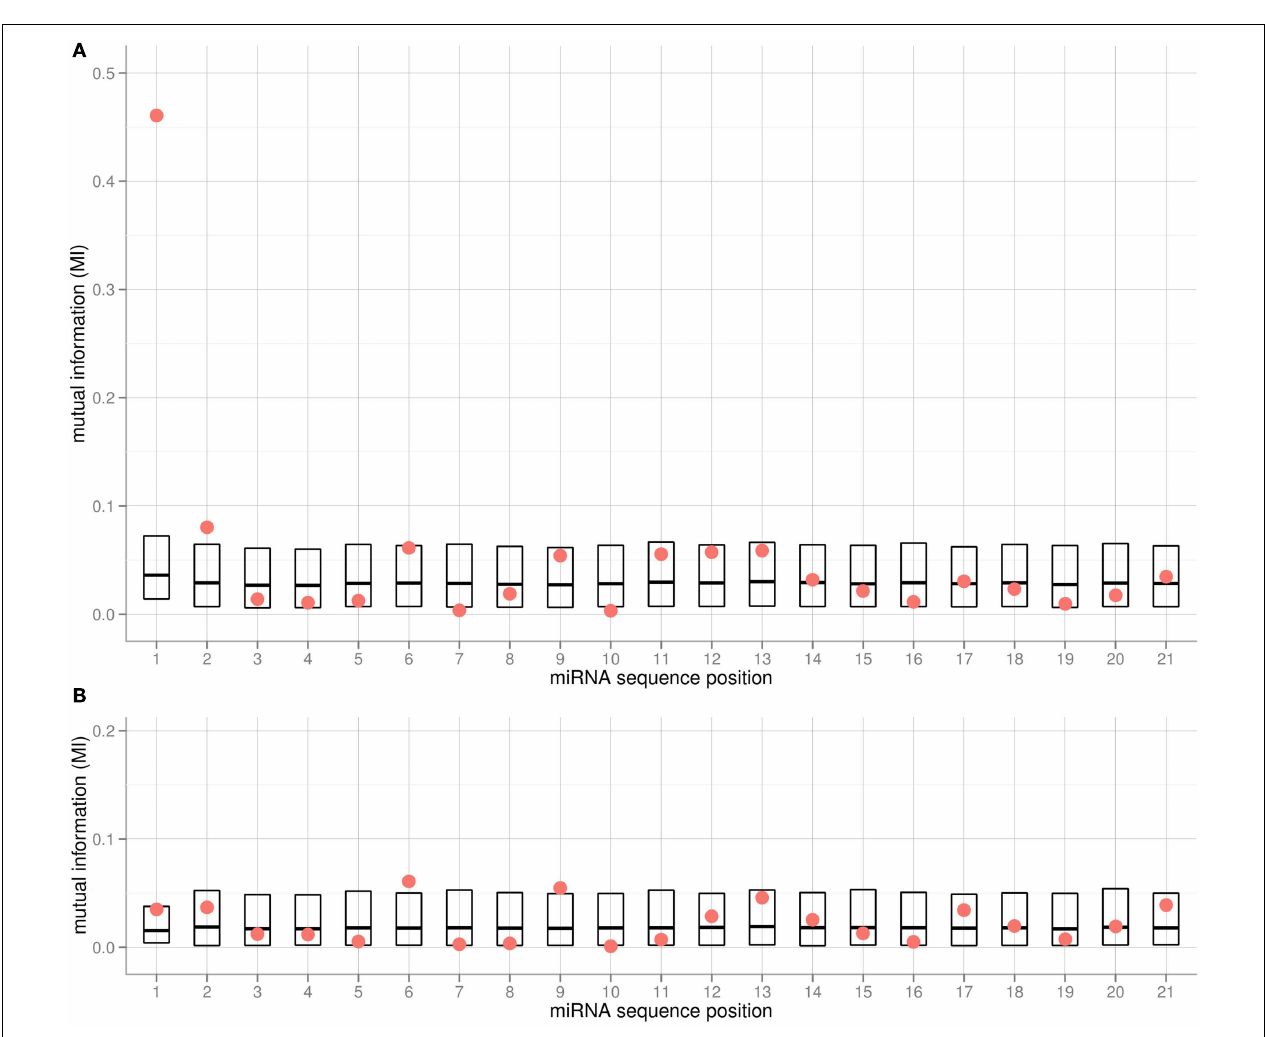
showing 5% percentile, mean and 95% percentile of 10,000 iterations). In (A) for position 1, the actual MI is significantly higher than for the MI shuffled data ( p FDR < 0.0021). Note that the shuffling was done per position, such that different base compositions leading to different background distributions are taken into